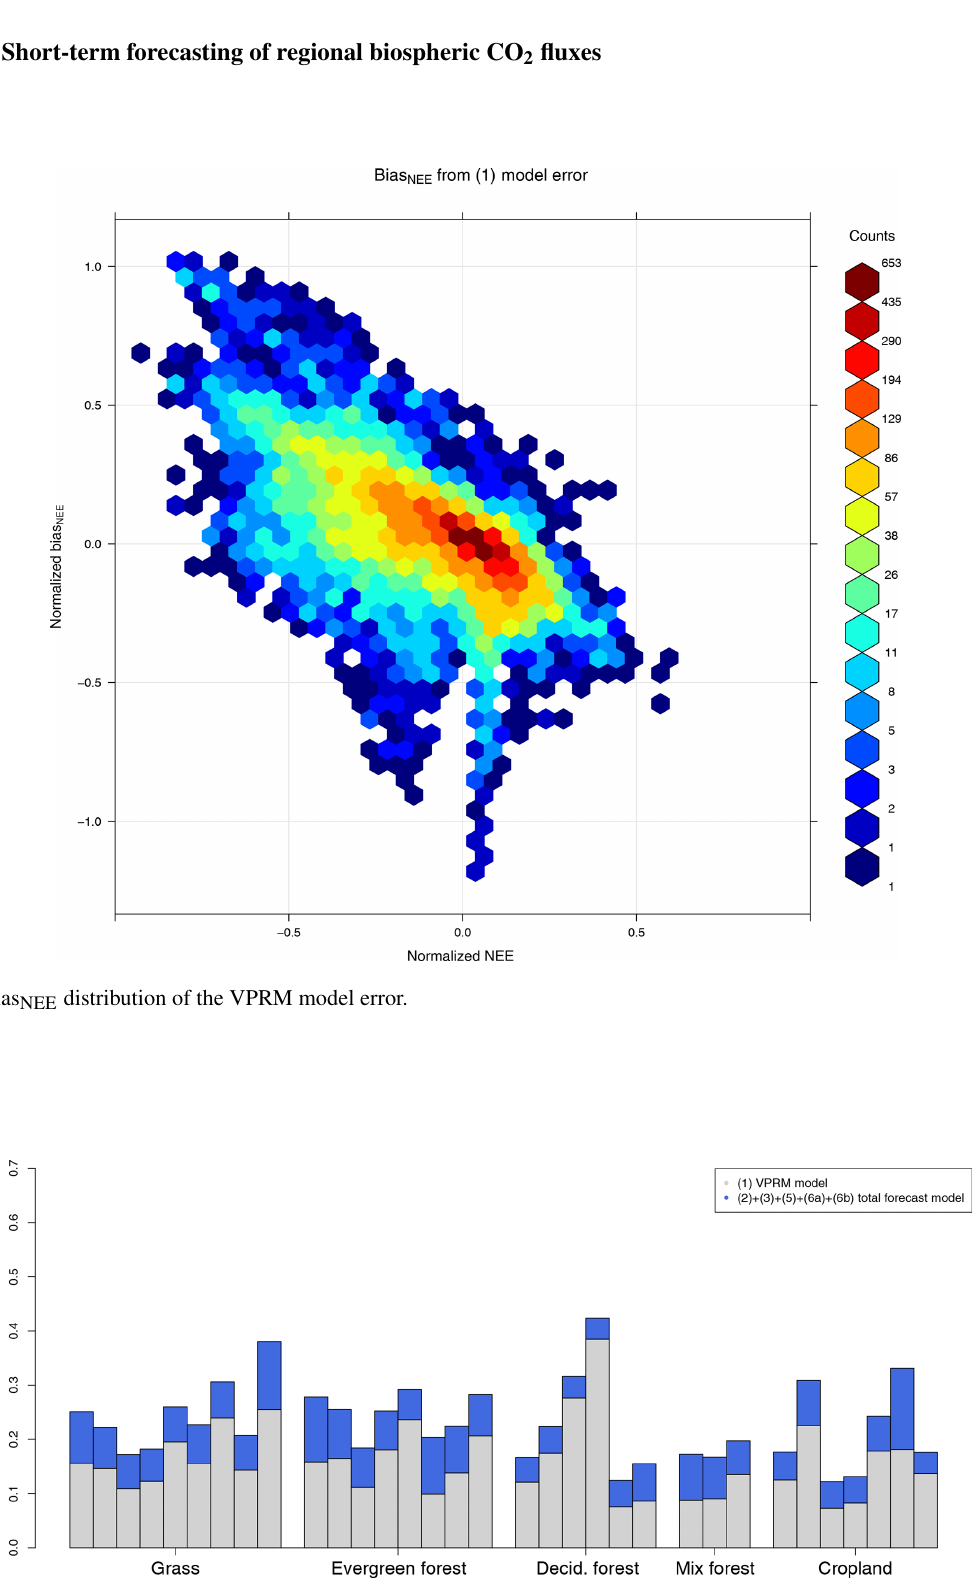
Figure 8. Mean absolute error of the forecast error compared to the VPRM model error at each flux observation site. The model error (1) is generally larger than the total forecast error (2) to (6), and the forecast error does not differ significantly across vegetation types. The order of the flux site is the same as in Fig.